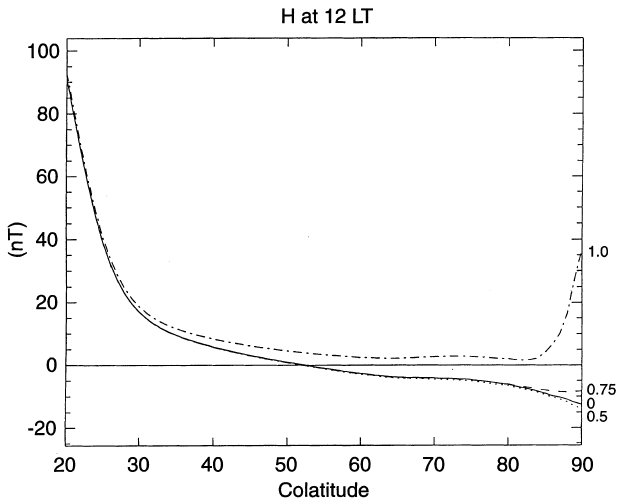
Fig. 4. Latitudinal variations of H component of magnetic fields in the 12 LT meridian calculated for the four models of S of the labels are same as Fig. 3